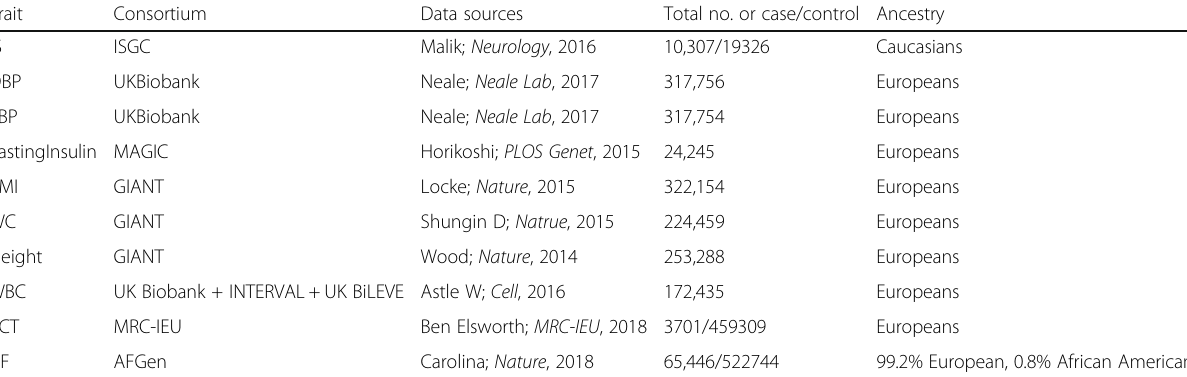
Table 1 Summary statistics data sources